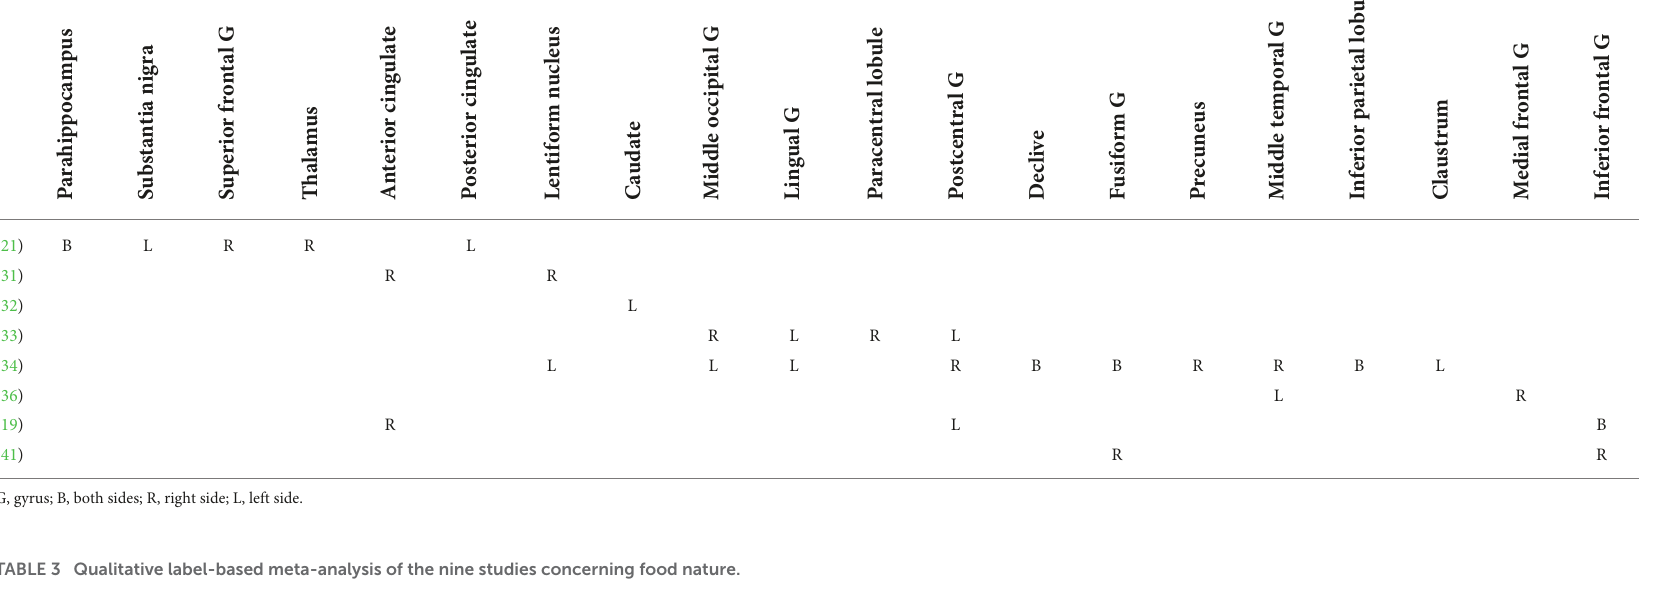
TABLE 3 Qualitative label-based meta-analysis of the nine studies concerning food